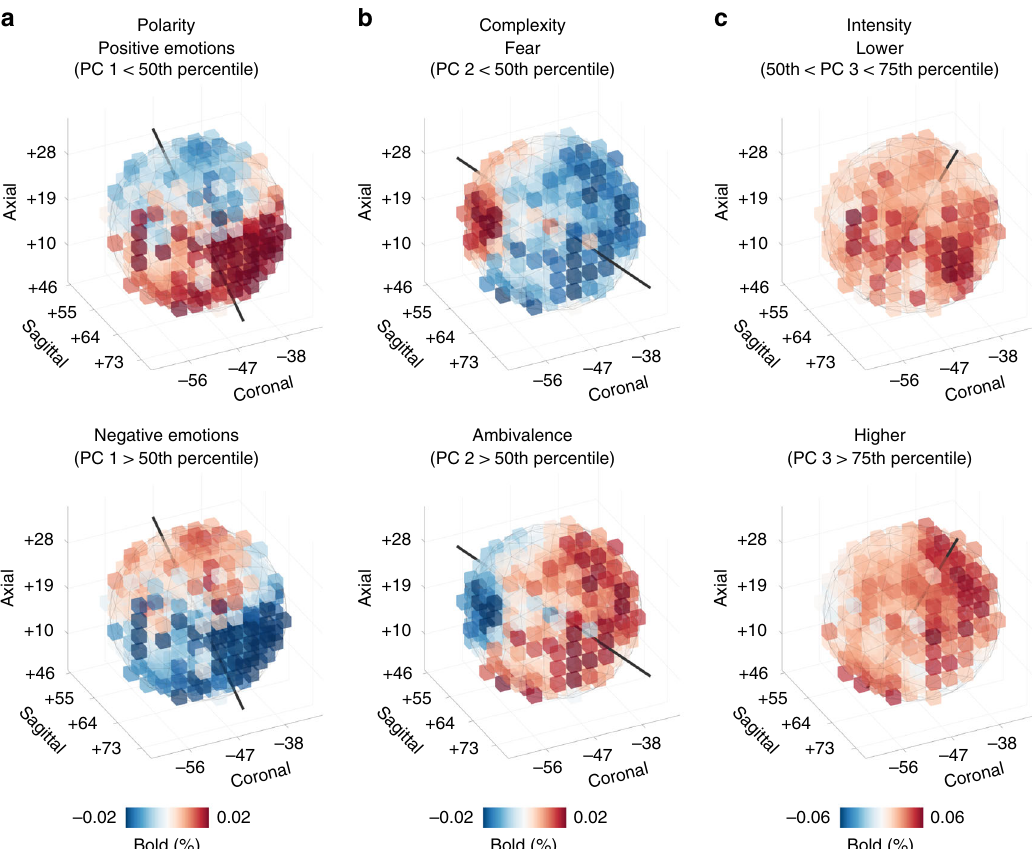
Fig. 5 Characterization of emotion dimension gradients in right TPJ. a Right TPJ hemodynamic activity related to the scores below and above the 50th percentile for polarity. b Right TPJ hemodynamic activity related to the scores below and above the 50th percentile for complexity. c Since intensity is not bipolar as the other two components (i.e., scores ranged from ~0 to positive values only), for this dimension we mapped the average TPJ activity above the 75th percentile and within 50th and 75th percentile. PC principal